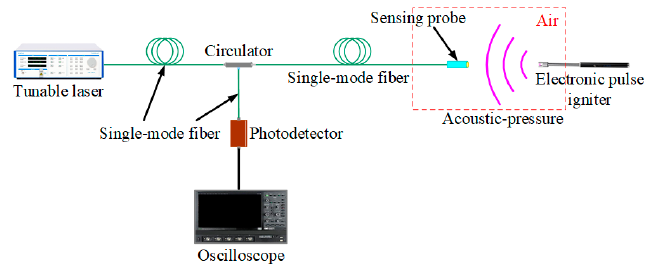
Figure 13. Particle discharge (PD) detection platform.